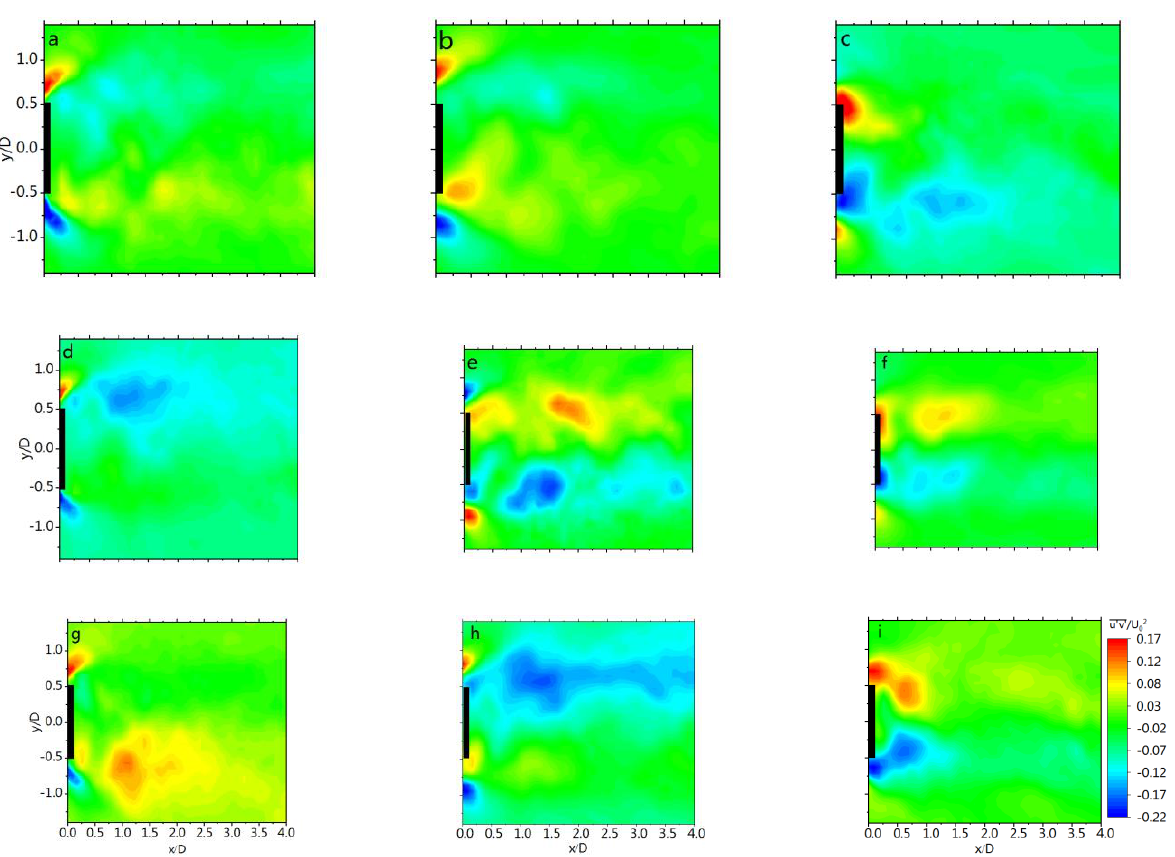
Figure 6. Reynold shear stress distribution: ( a ) Ar = 0.2, Re = 1000; ( b ) Ar = 0.3, Re = 1000; ( c ) Ar = 0.5, Re = 1000; ( d ) Ar = 0.2, Re = 2000; ( e ) Ar = 0.3, Re = 2000; ( f ) Ar = 0.5, Re = 2000; ( g ) Ar = 0.2, Re = 5000; ( h ) Ar = 0.3, Re = 5000; ( i ) Ar = 0.5, Re =